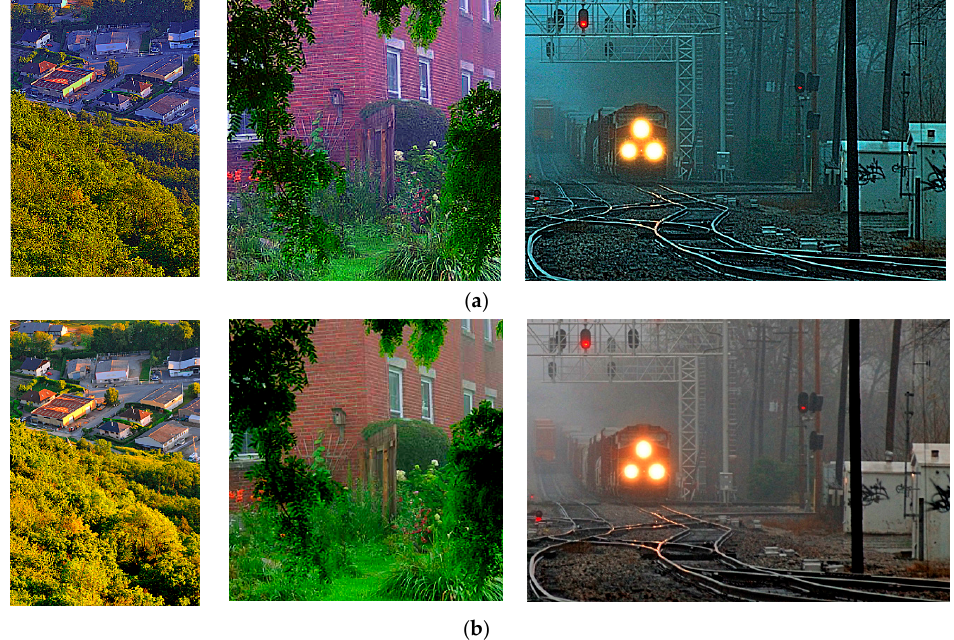
Figure 2. Processed images using ( a ) previous configuration ( b ) improved configuration of PA.